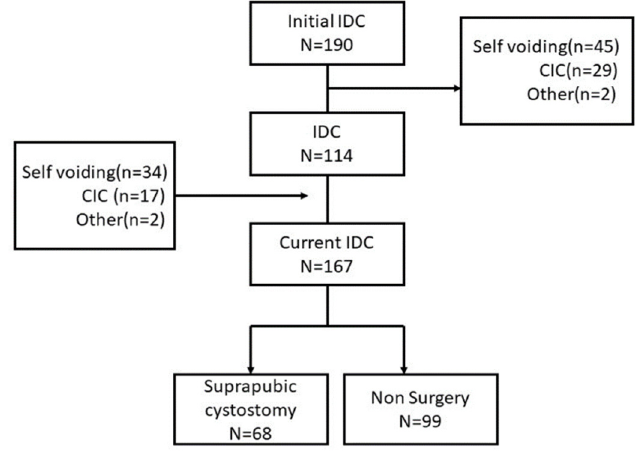
Figure 2. The flow chart of changing bladder management in the i nitial IDC group.